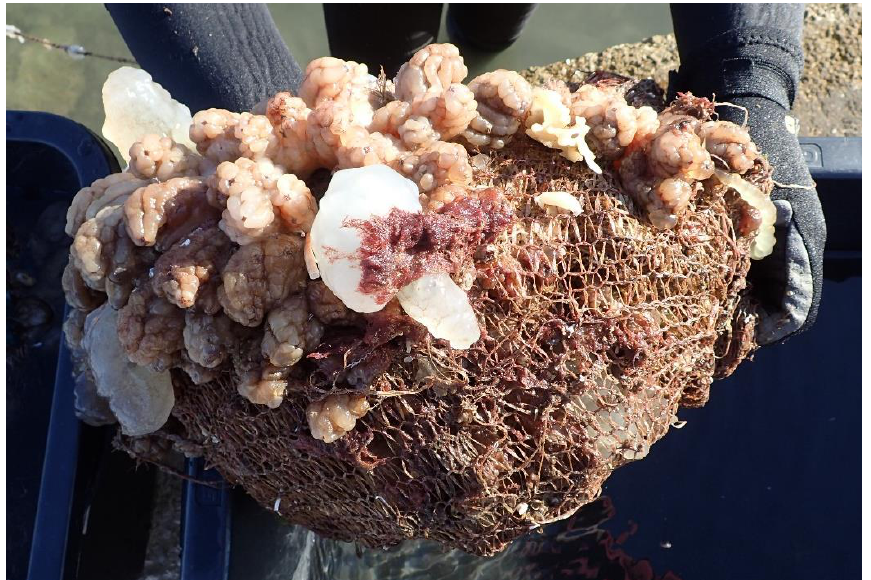
Figure 11. A larval collector bag from Luka Cove full and almost completely covered with invasive ascidian Styela plicata . The central part houses a solitary ascidian, Phallusia mammillata , on which the invasive bryozoan Bugula neritina can be seen.